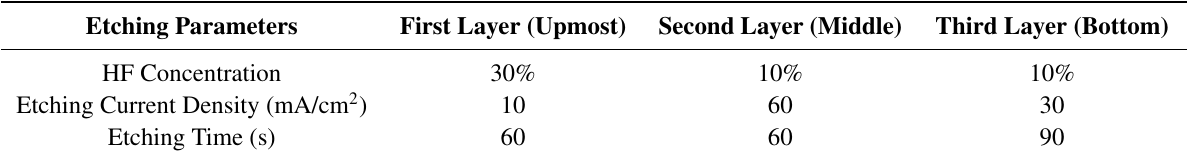
Table 1. Electrochemical-etching parameters used in the anodization process for preparation of the triple stacked PS